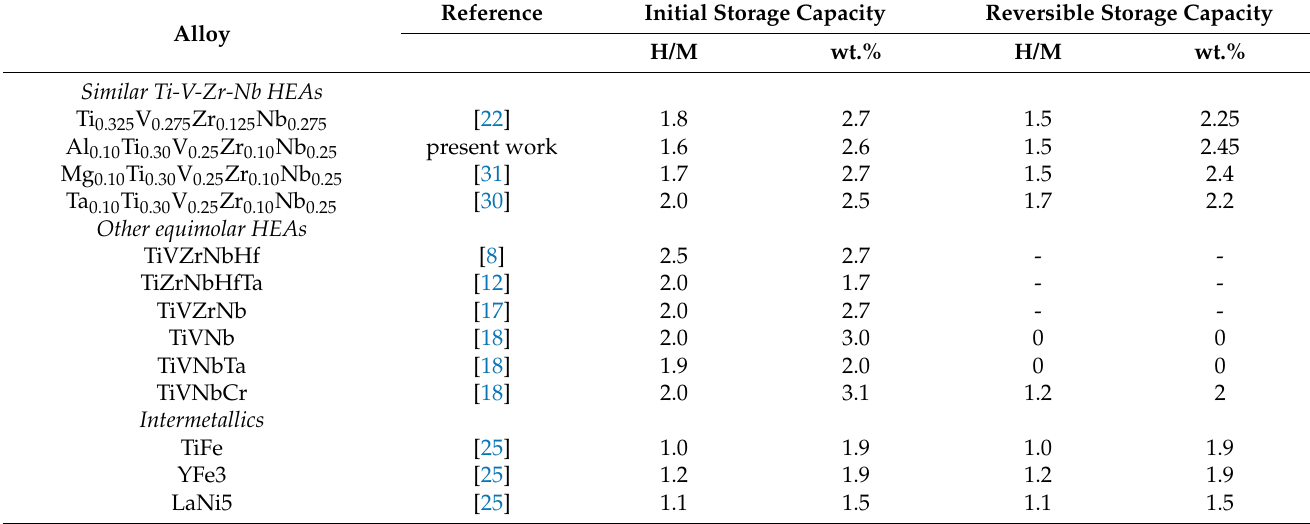
Table 3. Hydrogen storage capacities of several high-entropy alloys and intermetallics with their respective reversible capacity (if reported). Reference Initial Storage Capacity Reversible Storage Capacity Alloy H/M wt.% H/M wt.% Similar Ti-V-Zr-Nb